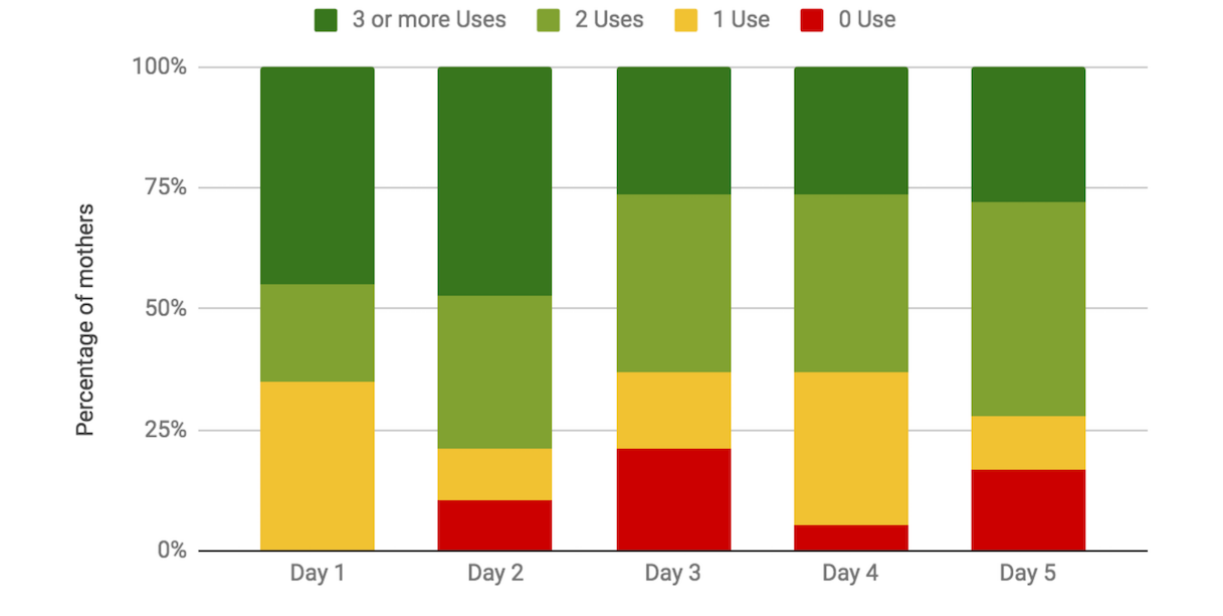
Figure 6. Distribution of the percentage of mothers who used the device unprompted 0 times, 1 time, 2 times, and 3 times or more, over the course of 5 days. Most mothers used NeMo 2 or more times a day, and very few mothers failed to use the device on any given